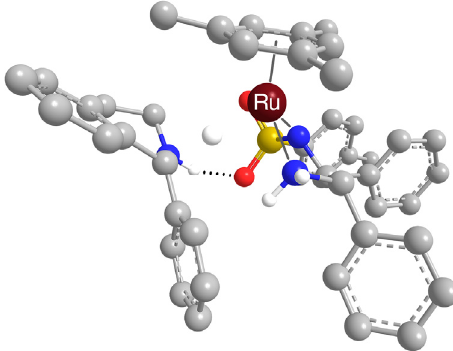
Figure 7. Transition state of hydrogenation of 1-phenyl-DHIQ with [RuH( η 6 -